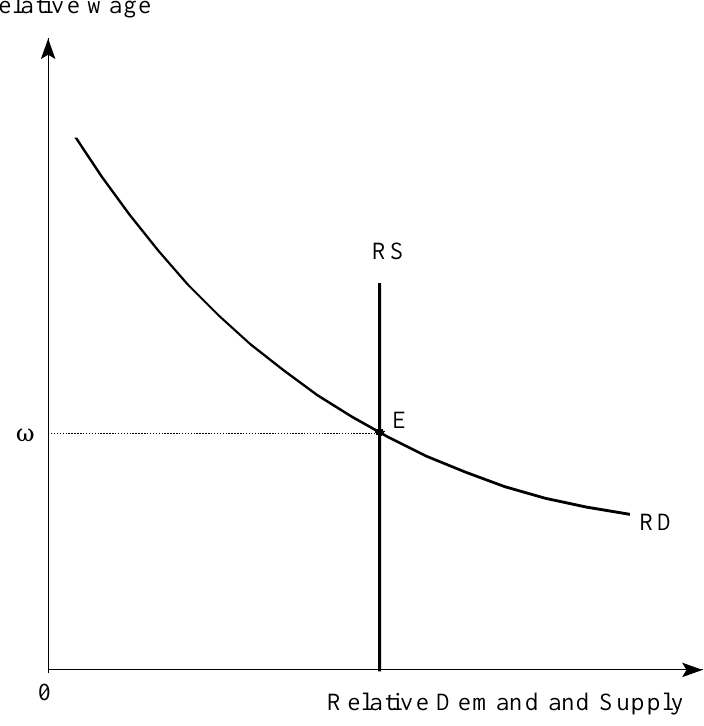
Figure 1. Steady-State Integrated-World